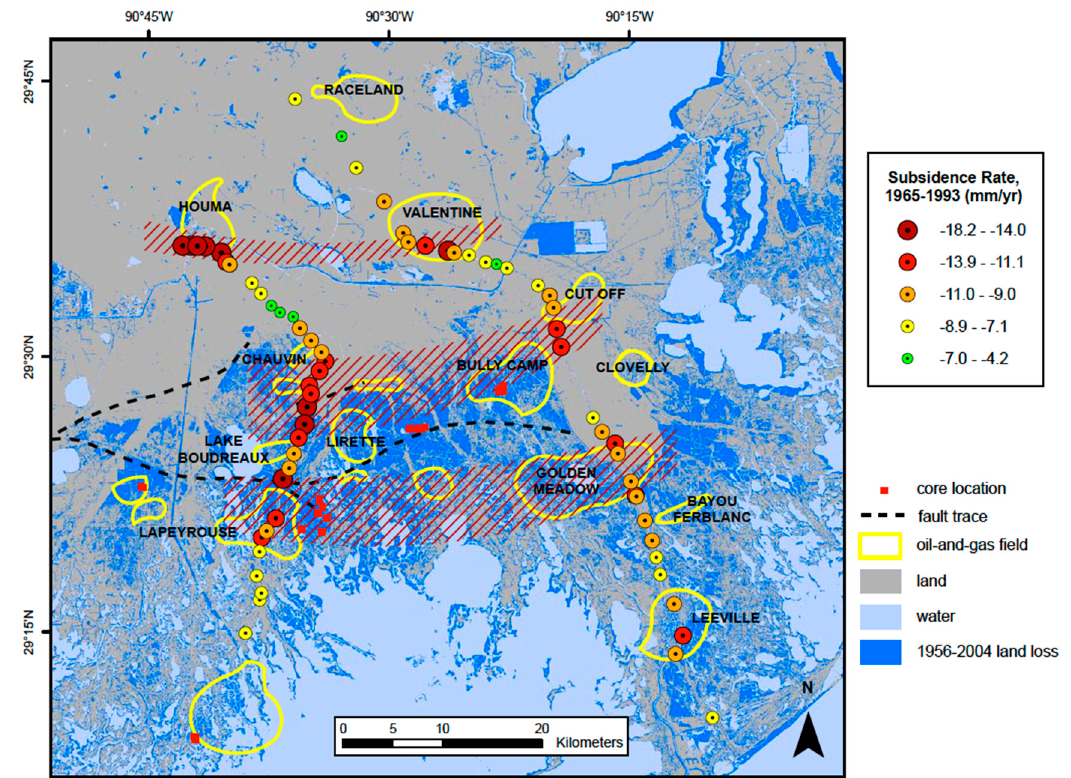
Figure 12. Map showing average subsidence rates between 1965 and 1993 in south Louisiana. Areas of highest subsidence rates (>12 mm/year; hatched pattern) correlate closely with locations of oil and gas fields. Lowest average subsidence rates are located between major producing fields [30].